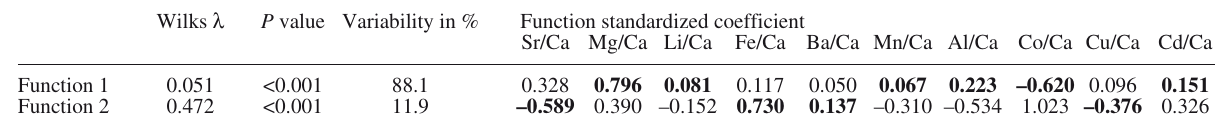
Table 6. – Results of CDA carried out on elemental ratios. Coefficient-driven functions 1 and/or 2 are presented in bold characters. Wilks l P value Variability in